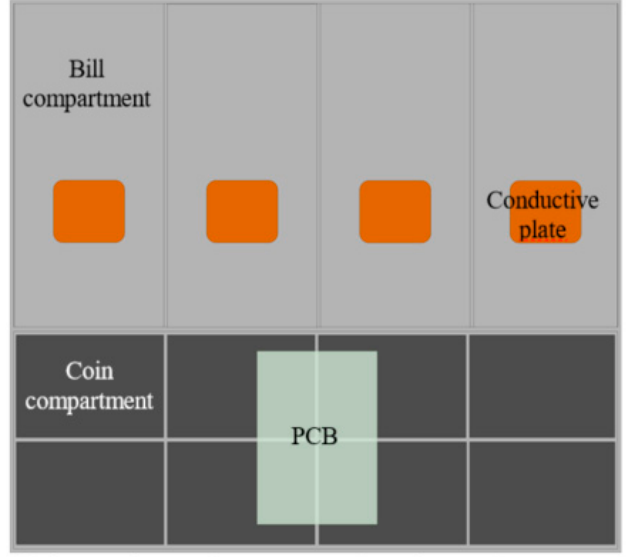
Figure 13. 3D rendering of the workpiece the conductive plate of the parallel capacitor is glued to. This is an element of the new bill holder.